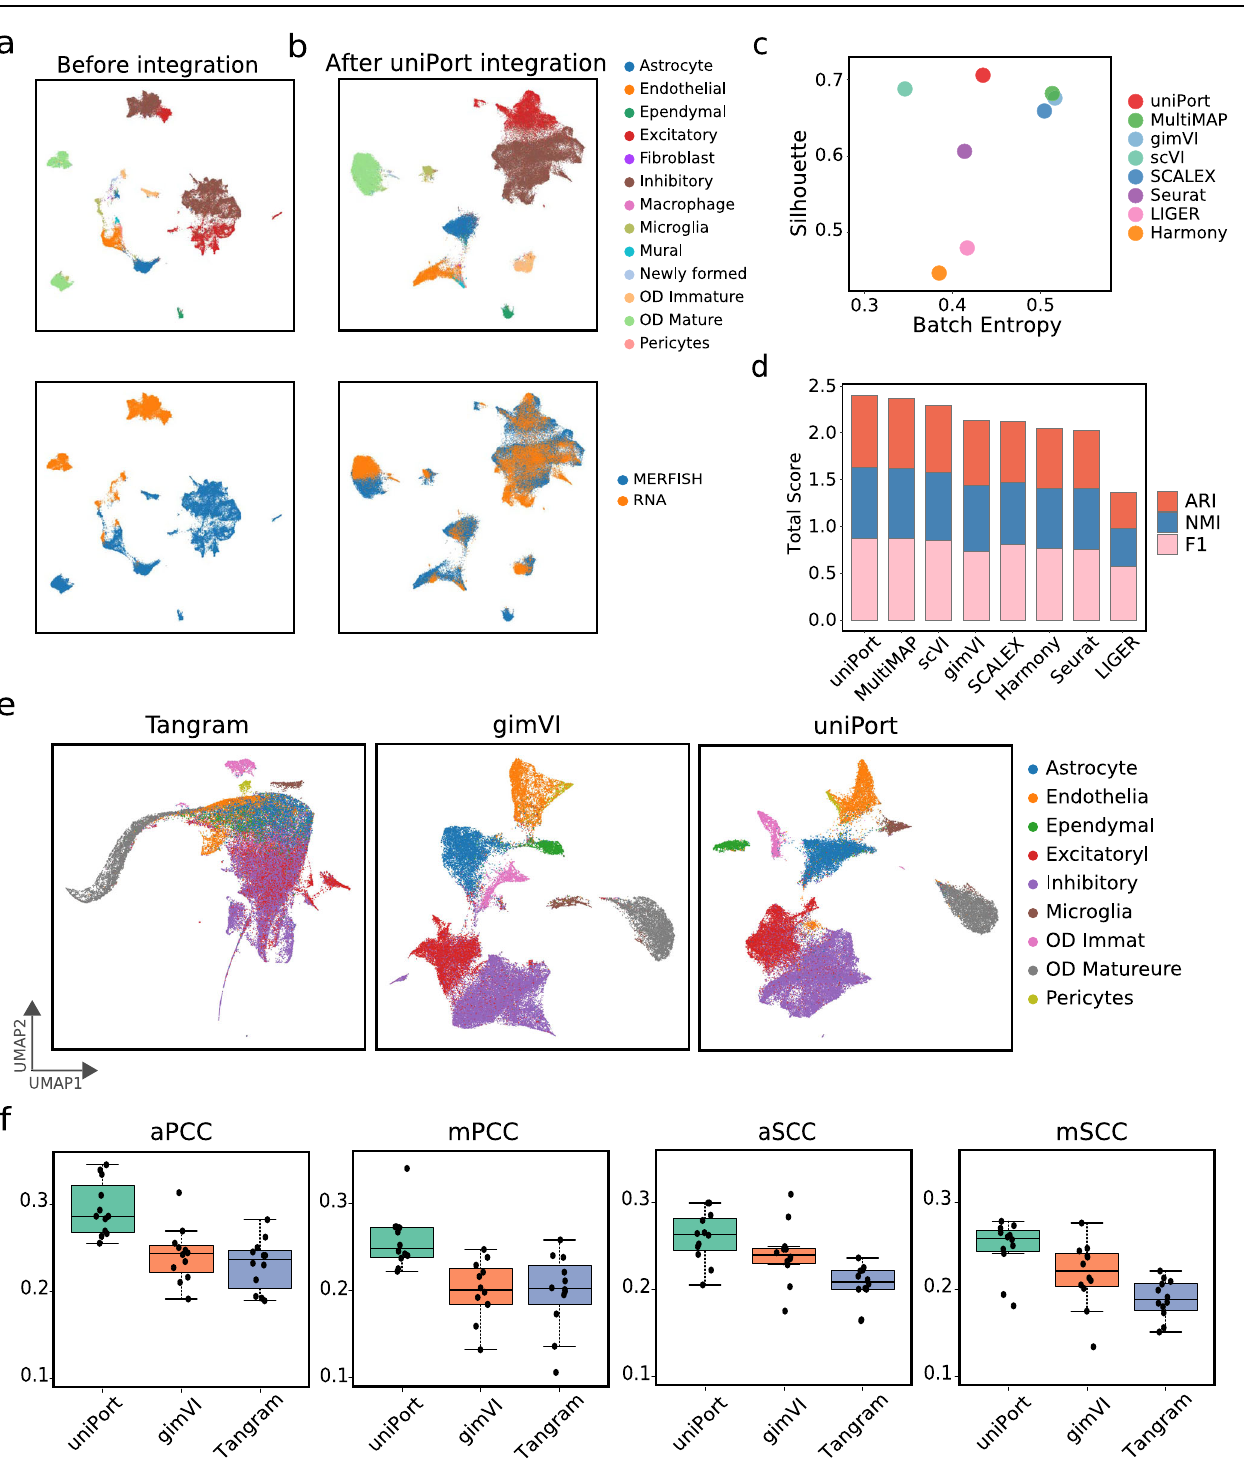
Fig. 5 | uniPort imputes MERFISH genes through scRNA data. a UMAP visuali- zation of MERFISH and scRNA data before integration. b UMAP visualization of MERFISHandscRNAdataafteruniPortintegration. c ComparisonofBatchEntropy scores and Silhouette coef fi cients of different methods. d Comparison of total scores of ARI, NMI and F1 of different methods. e UMAP visualization of imputed MERFISH genes of Tangram, gimVI and uniPort. f Boxplots of average and median